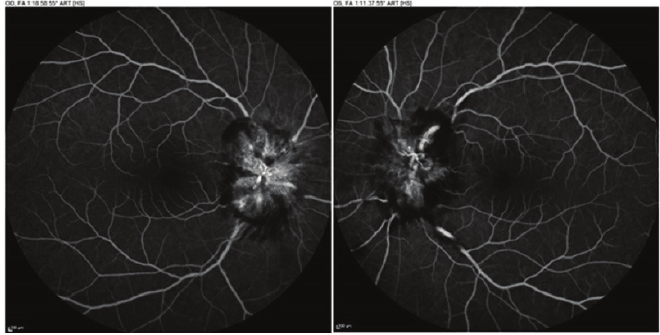
Figure 4. Fluorescein angiography shows disc leakage in both eyes, suggestive of disc